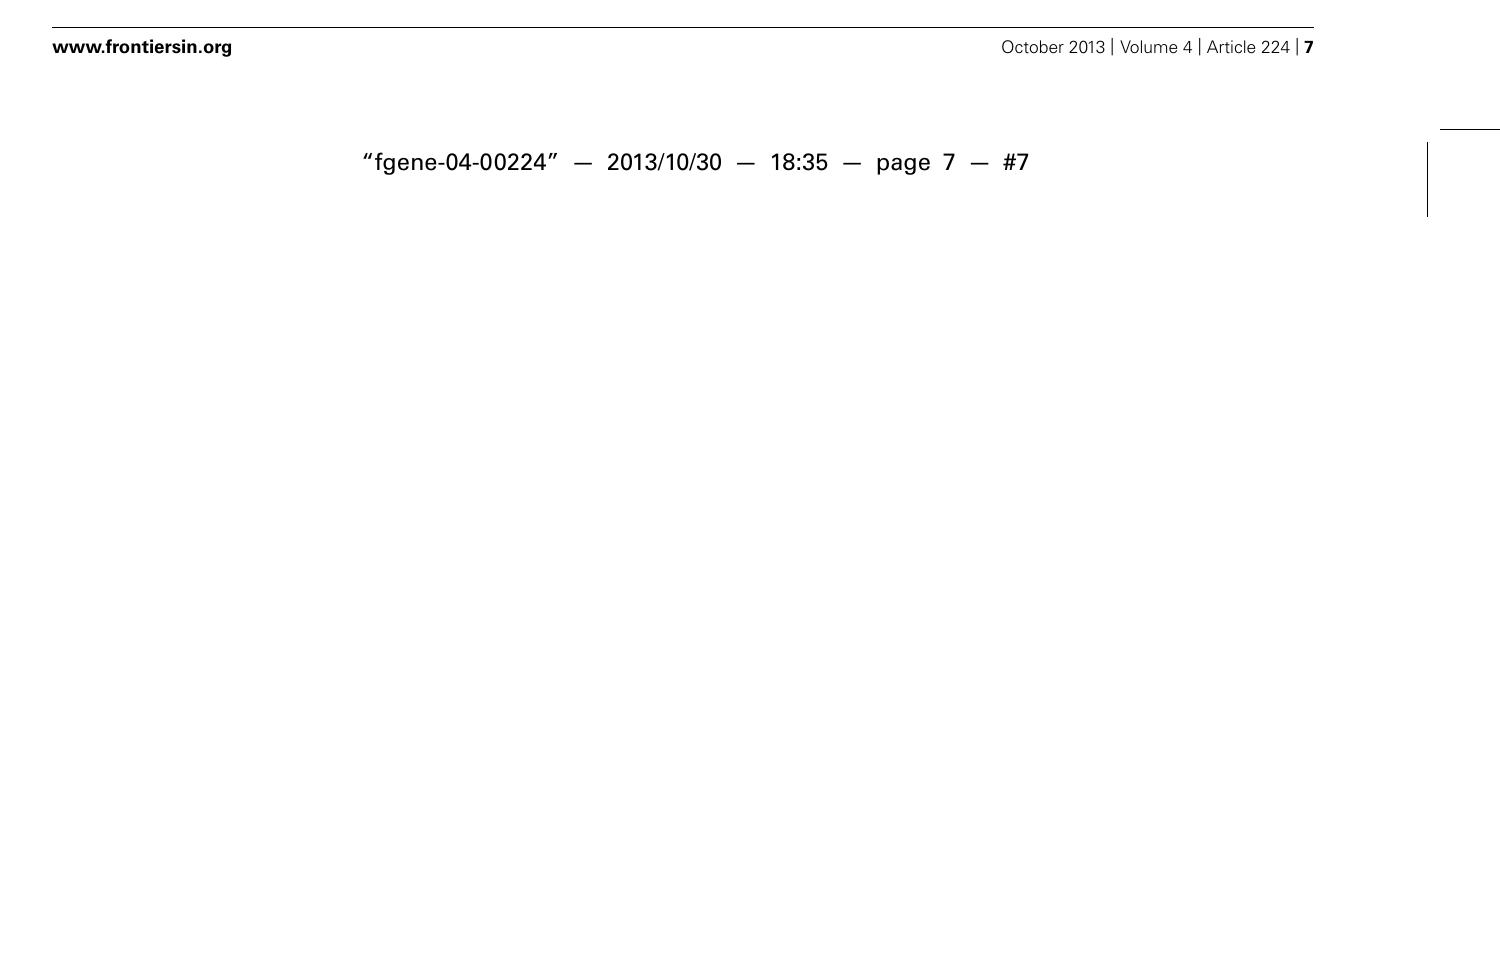
pair-fed wild type of middle age; ME, alcohol-fed wild type of middle age; OC, pair-fed knockout of older age; OE, alcohol-fed knockout of older age; (A) representative western blots of the selective ER stress markers; (B) relative expression of each marker protein; * p < 0.05 compared between pair-fed and alcohol-fed; α p < 0.05, αα p < 0.01 compared between alcohol-fed middle and older mice of same genotype. n =